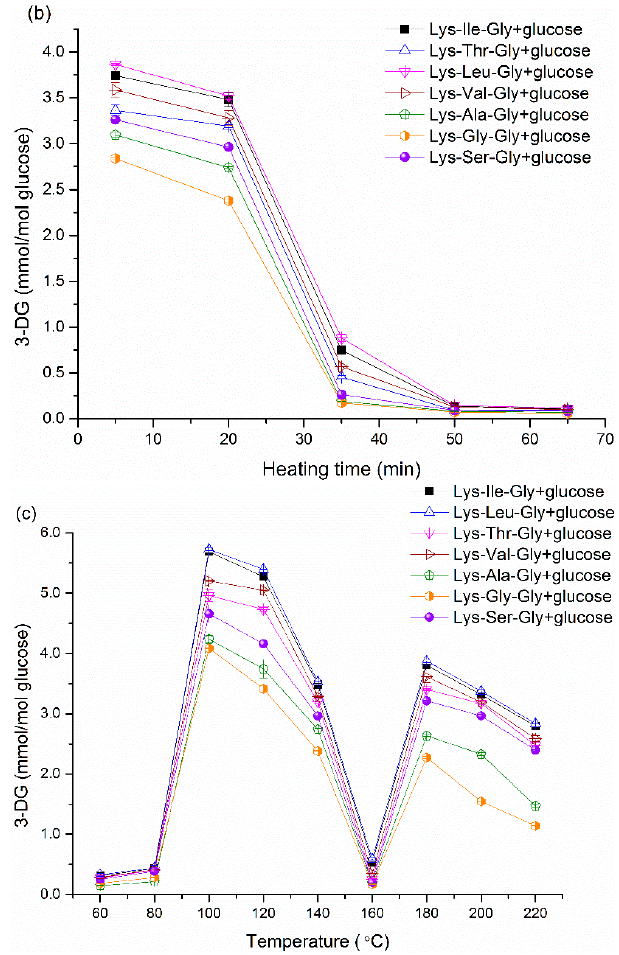
Figure 2. 3-DG content in the heat-treated tripeptide-glucose mixtures, ( a ) tripeptide-glucose mixtures at different initial molar ratios, time 20 min, temperature 140 °C; ( b ) tripeptide-glucose mixtures at various heat-treated times, initial molar ratio 1:1, temperature 140 °C; ( c ) tripeptide-glucose mixtures various heat-treated times, initial molar ratio 1:1, temperature 140 ˝ C; ( c ) tripeptide-glucose at different heating temperatures, initial molar ratio 1:1, time 20 min.